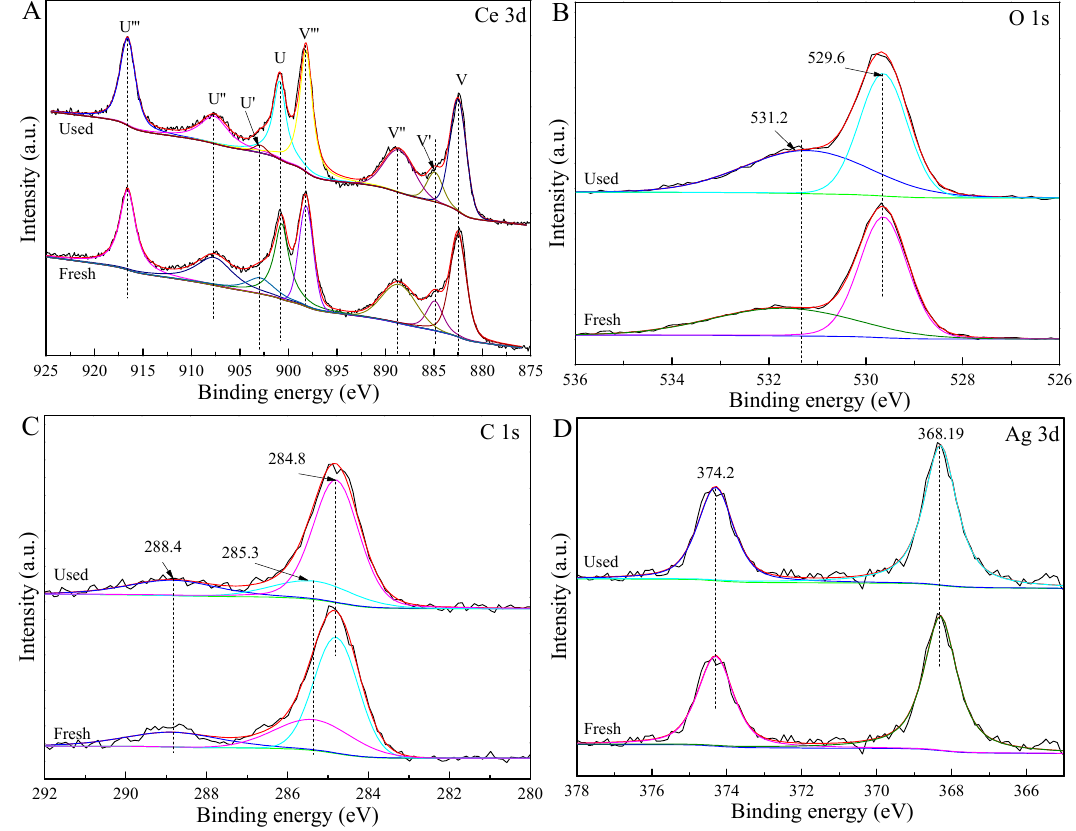
Figure 2. Ce 3d ( A ), O 1s ( B ), C 1s ( C ), and Ag 3d ( D ) X-ray photoelectron spectroscopy (XPS) spectra of fresh and used 3-Ag/CeO 2 @C-2.